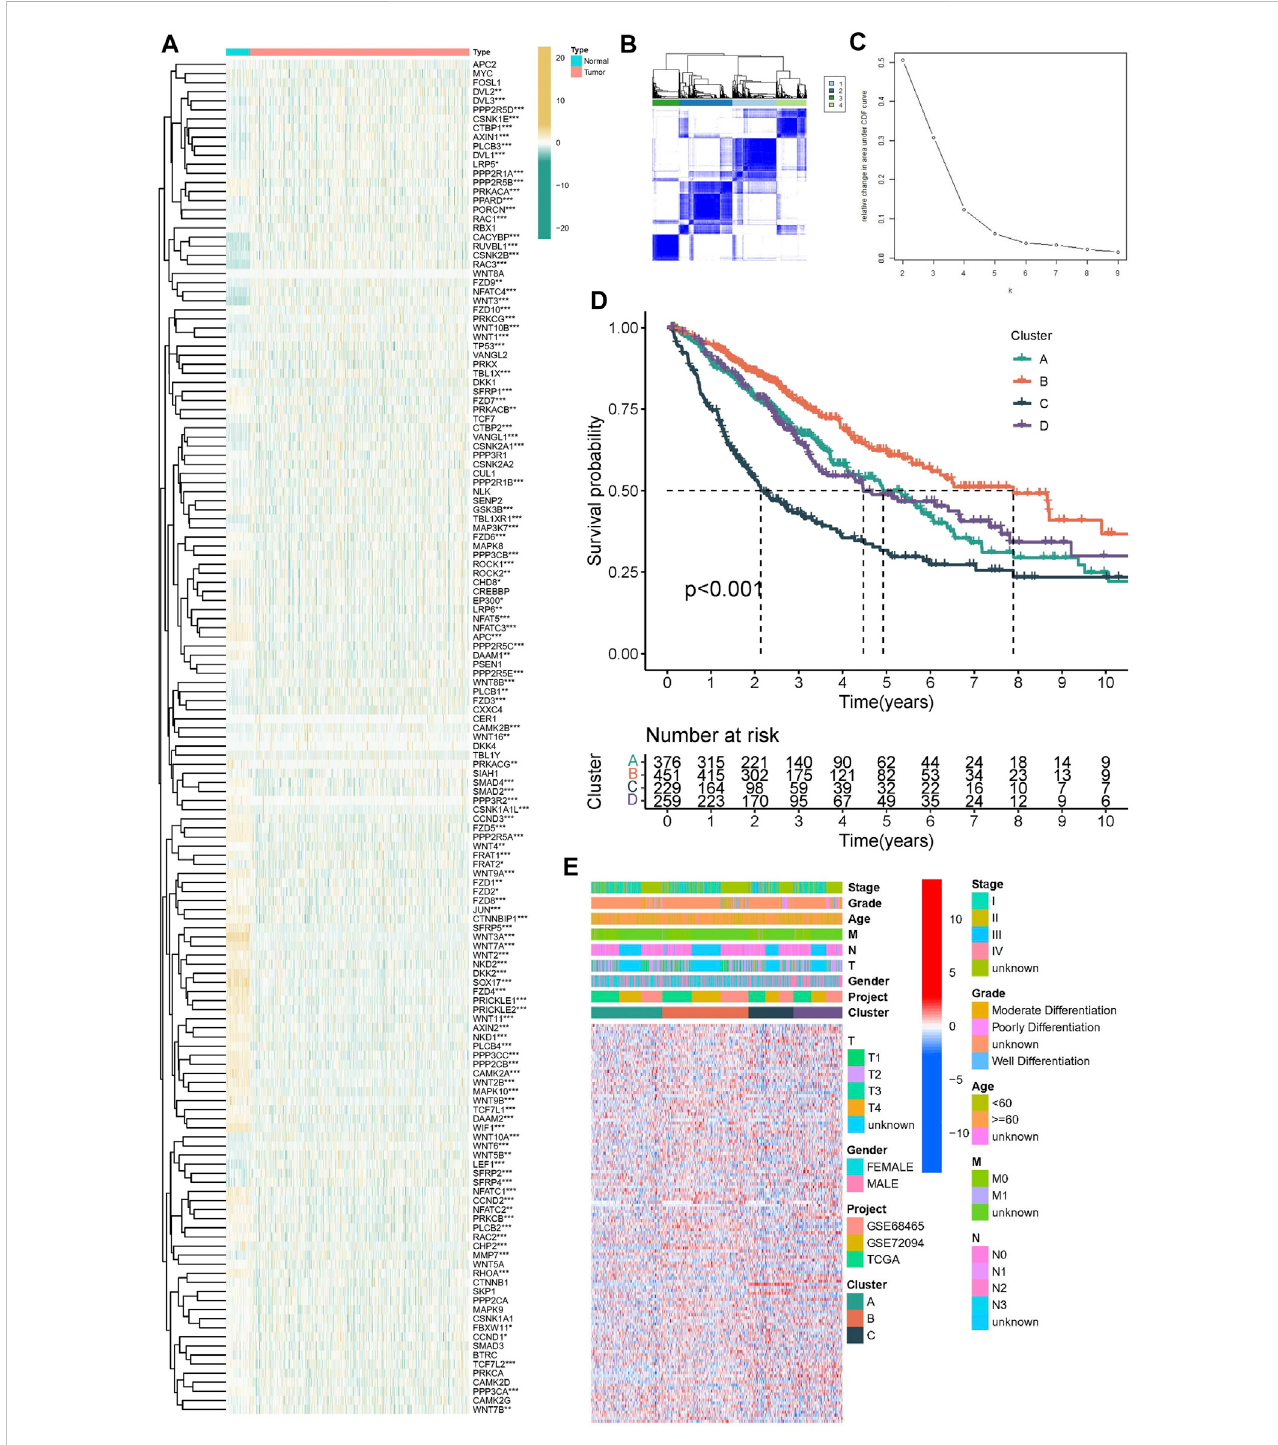
FIGURE 2 Construction of molecular subtypes in lung adenocarcinoma. (A) The heatmap was utilized to present the transcriptome pattern of 152 wtn signal pathway related genes in distinct samples. (B,C) Unsupervised clustering was conducted to divided samples into four subgroups performed according to the 152 wtn signal pathway related genes patterns. (D) Kaplan – Meier survival model for lung adenocarcinoma, p < 0.001. (E) The heatmap was utilized to present the transcriptome pattern of 152 wtn signal pathway related genes in distinct subtypes. Red/blue represented high/low expression of genes. The comments on the right include TNM stage, clinical grade/stage, gender, age, project and cluster,